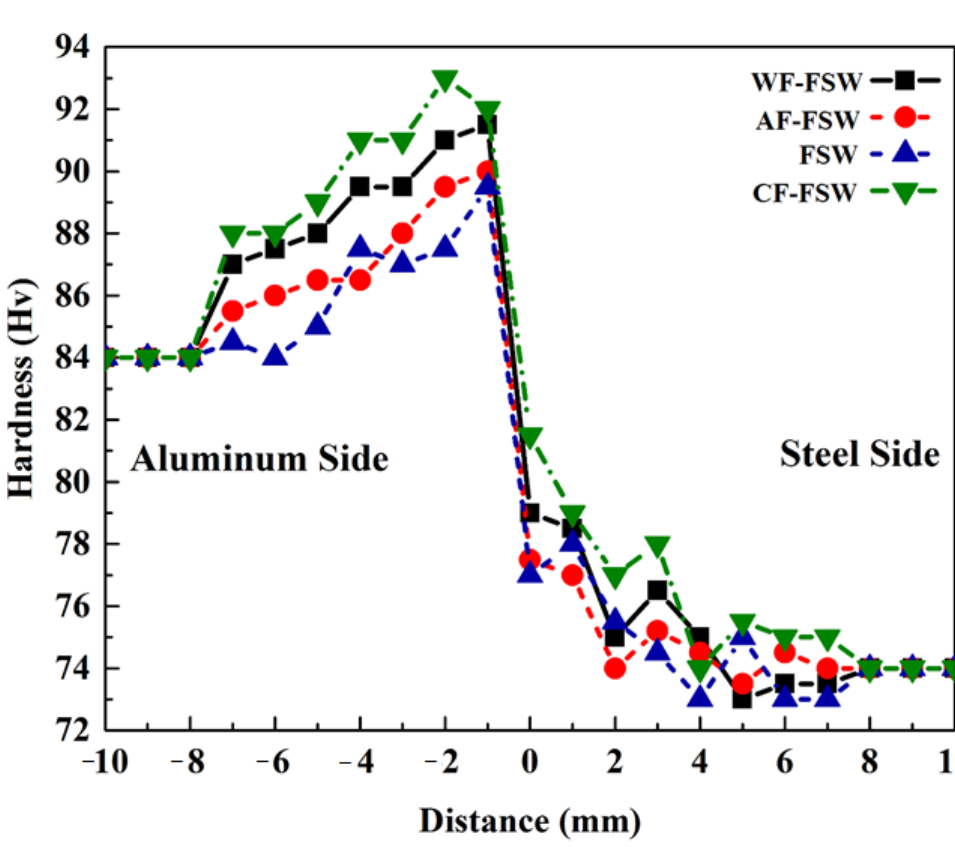
Figure 8 Figure 8. Hardness evaluation of each cooling condition according to